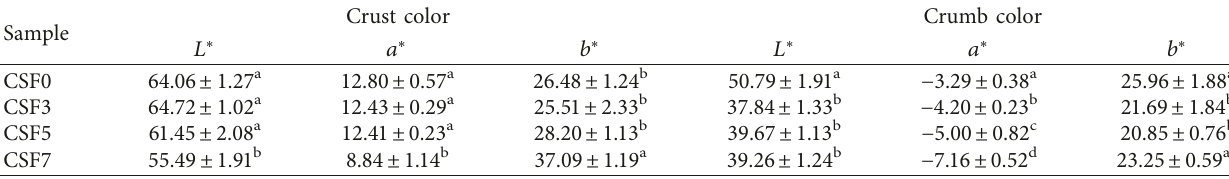
Table 6: Effect of replacing egg by chia seed flour on color characteristics of cake.